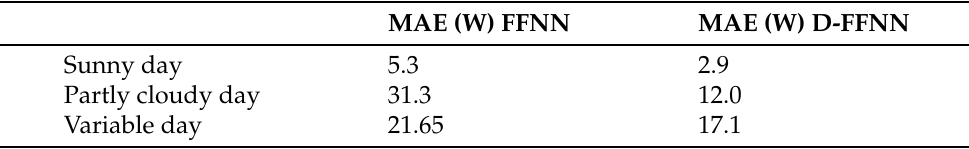
Table 5. Mean Absolute Error (MAE) achieved by the reconfigurable ANN.